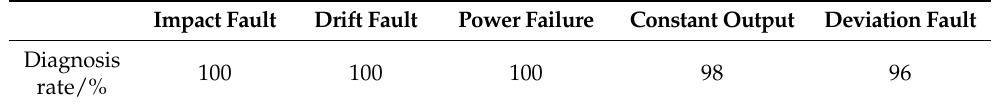
Table 1. The diagnostic accuracy of the different